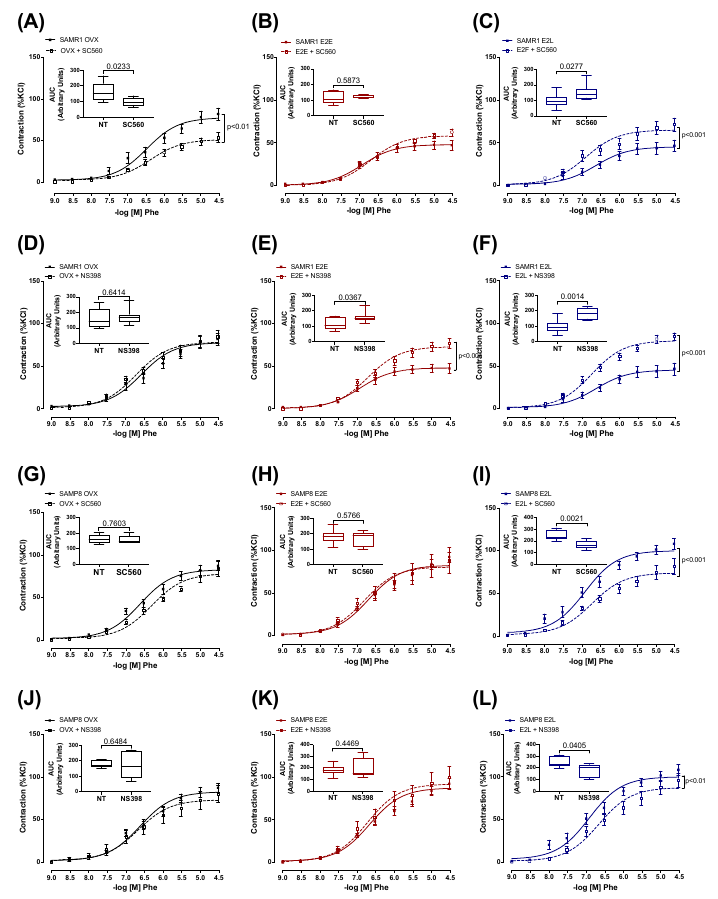
Figure 3. Role of COX-derived prostaglandins in phenylephrine-induced contractions. Concentration–response curves to phenylephrine (Phe) in the endothelium-intact common carotid artery from SAMR1 ( A – F ) and SAMP8 ( G – L ). Arteries were isolated from untreated ovariectomized mice (OVX) or treated with early-onset of 17 β -estradiol treatment (E 2 E) or late-onset 17 β -estradiol treatment (E 2 L), as indicated. Curves were obtained in the absence or the presence of COX-1 (SC560, 10 − 6 M) or COX-2 (NS 398, 10 − 6 M) inhibitor. Inset graphs represent the areas under the curve (AUC) obtained from the curves of untreated carotids (NT) or those receiving selective COX inhibition. Each point represents the mean ± SEM from 5–10 independent experiments. The extra sum-of-squares F determined differences in the fit of concentration–response curves. One-way ANOVA analyzed the dependence of data on the onset of estrogen therapy (none, early, or late) in SAMR1 or SAMP8 with Bonferroni’s post-test. p -values and comparisons are expressed next to the curves and on top of bar graphs. Significance is considered when p < 0.05.